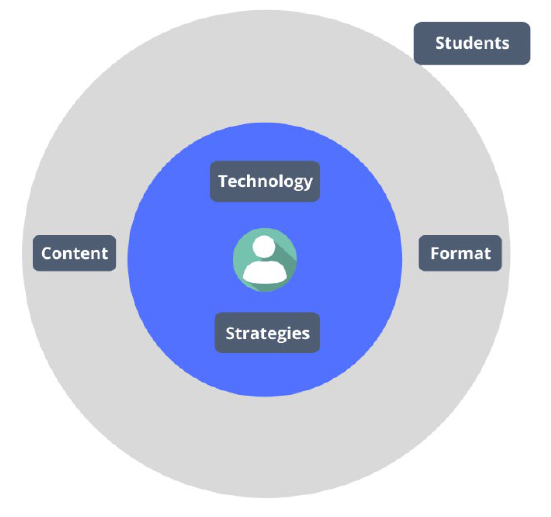
Figure 1. The Zones of Agency for Online Instructors